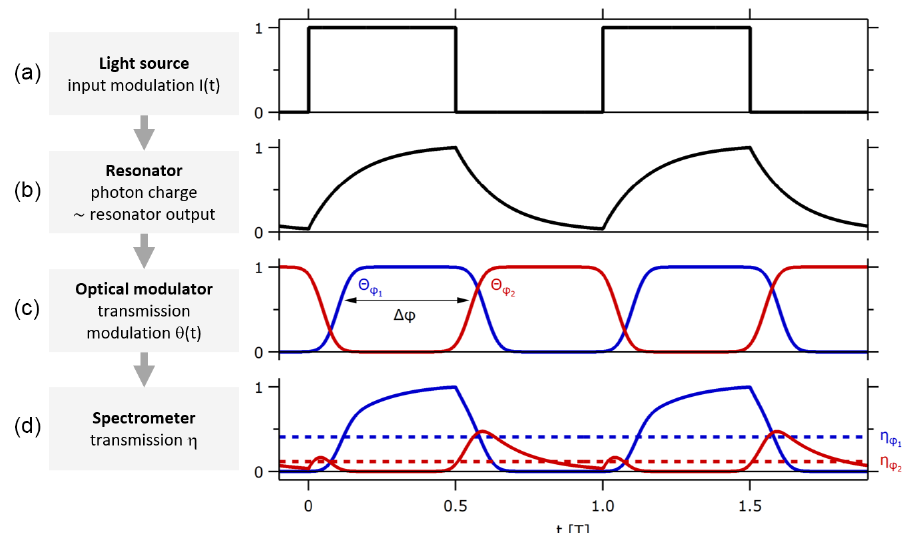
Figure 4. Temporal evolution of physical properties in apparatus within two exemplary pulse cycles: (a) light input I(t) from the light source, (b) photon population in the resonator or output towards the spectrometer, (c) transmission θ(t) of the optical modulator for two exemplary phases, and (d) instantaneous (solid) and apparent (dashed) transmission η to the detector. The apparent transmission η is a function of the phase φ , τ , I(t) , θ(t) , and the modulation frequency ν .